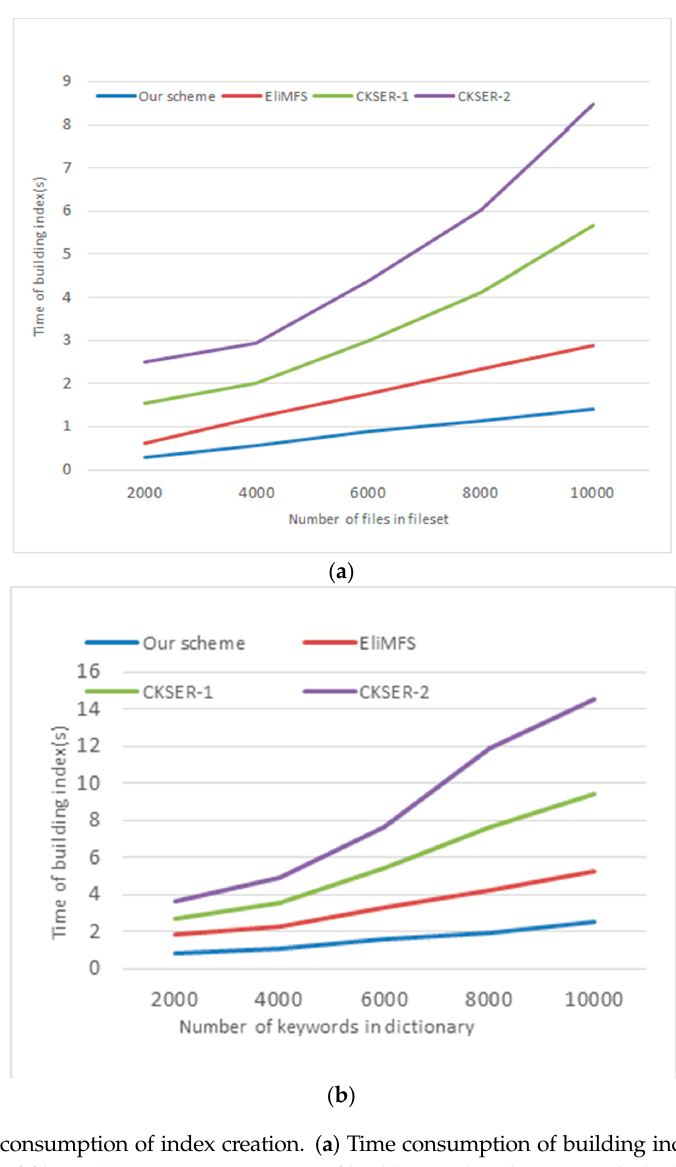
Figure 8. Time consumption of index creation. ( a ) Time consumption of building index changes with the file number of fileset; ( b ) Time consumption of building index changes with the keyword number of dictionary.